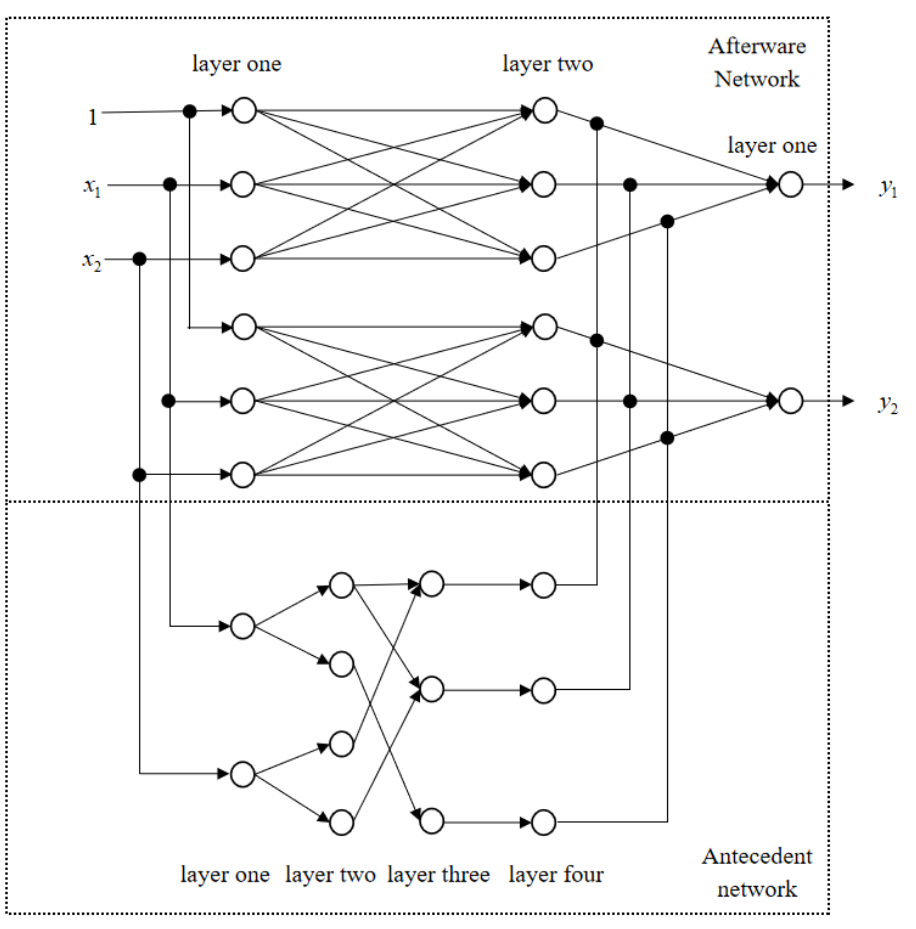
Figure 9. T-S fuzzy neural network structure